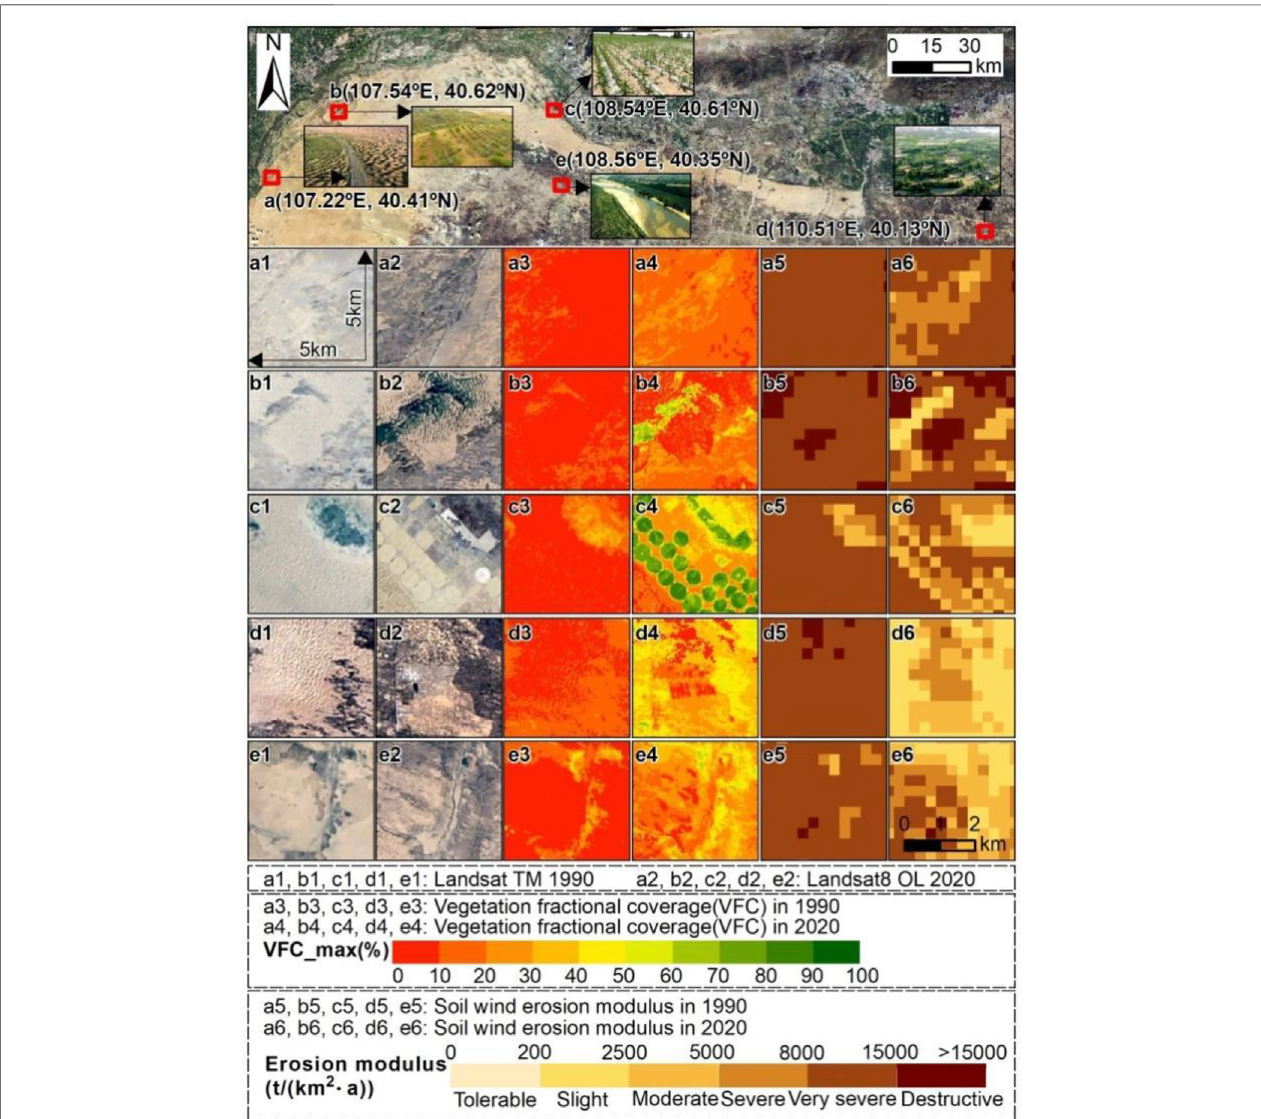
FIGURE 8 | Schematic diagram of the vegetation cover and soil – wind erosion intensity in typical areas of sandy land change.